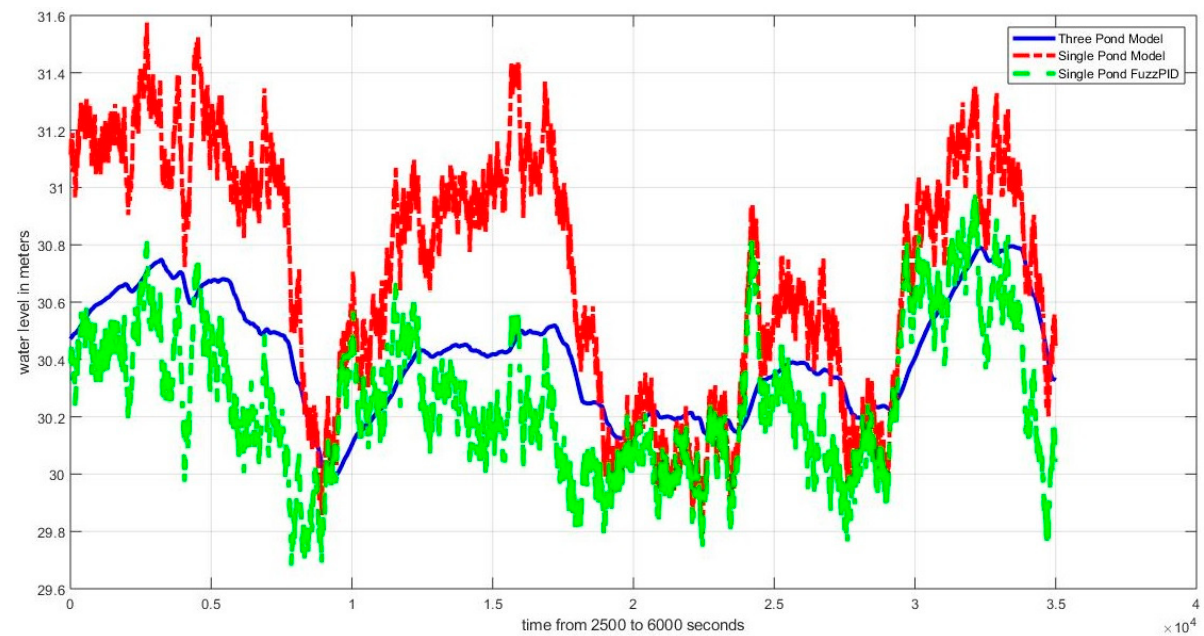
Figure 20. Traditional system (Fuzzy and FuzzyPID) vs. the proposed system (white noise disturbance, steady state).